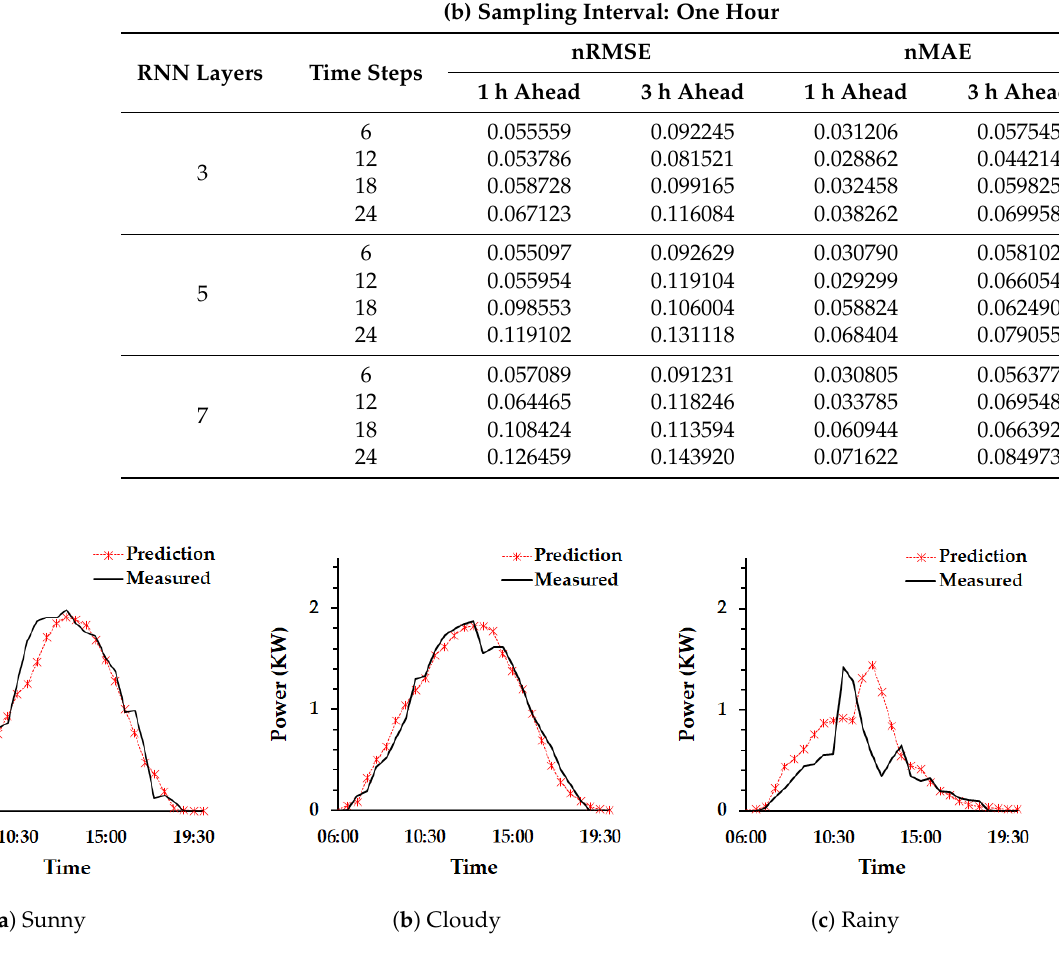
Figure 13. The 1 h ahead short-term forecast (SI = 30 m, PDL = 12 h, Layer = 3).